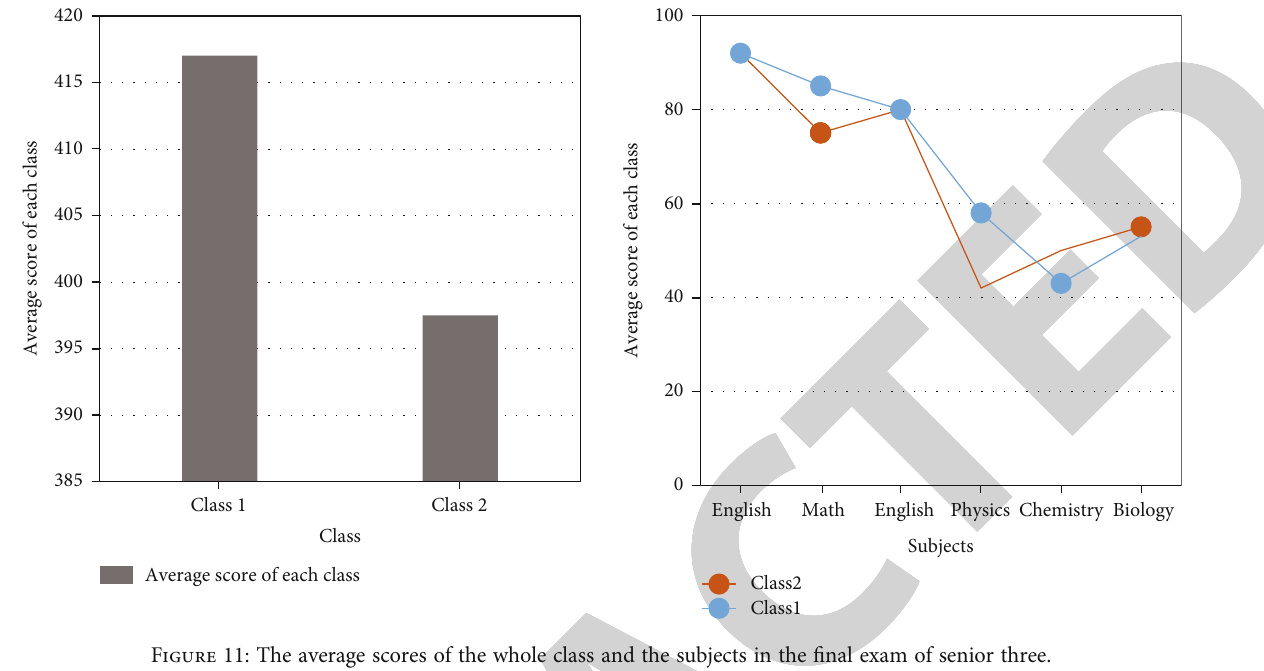
Figure 11: The average scores of the whole class and the subjects in the fi nal exam of senior